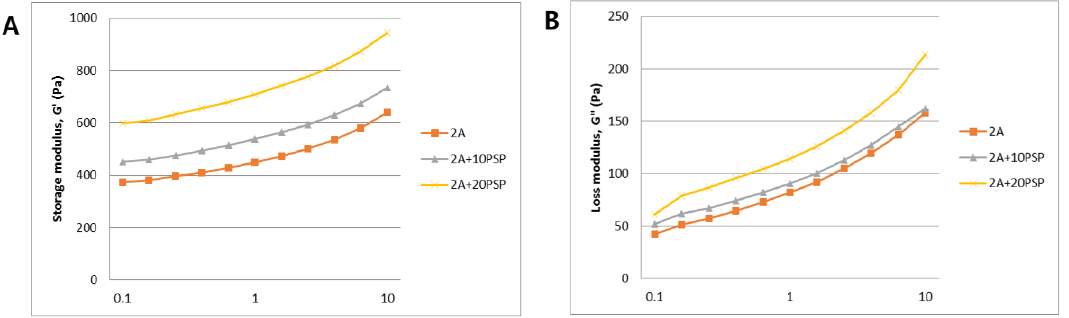
Figure 3. Mechanical properties of PSP-inks. The storage modulus G’ ( A ) and the loss modulus G” ( B ) were plotted logarithmically against frequency (0.1–10 Hz at 24 °C).